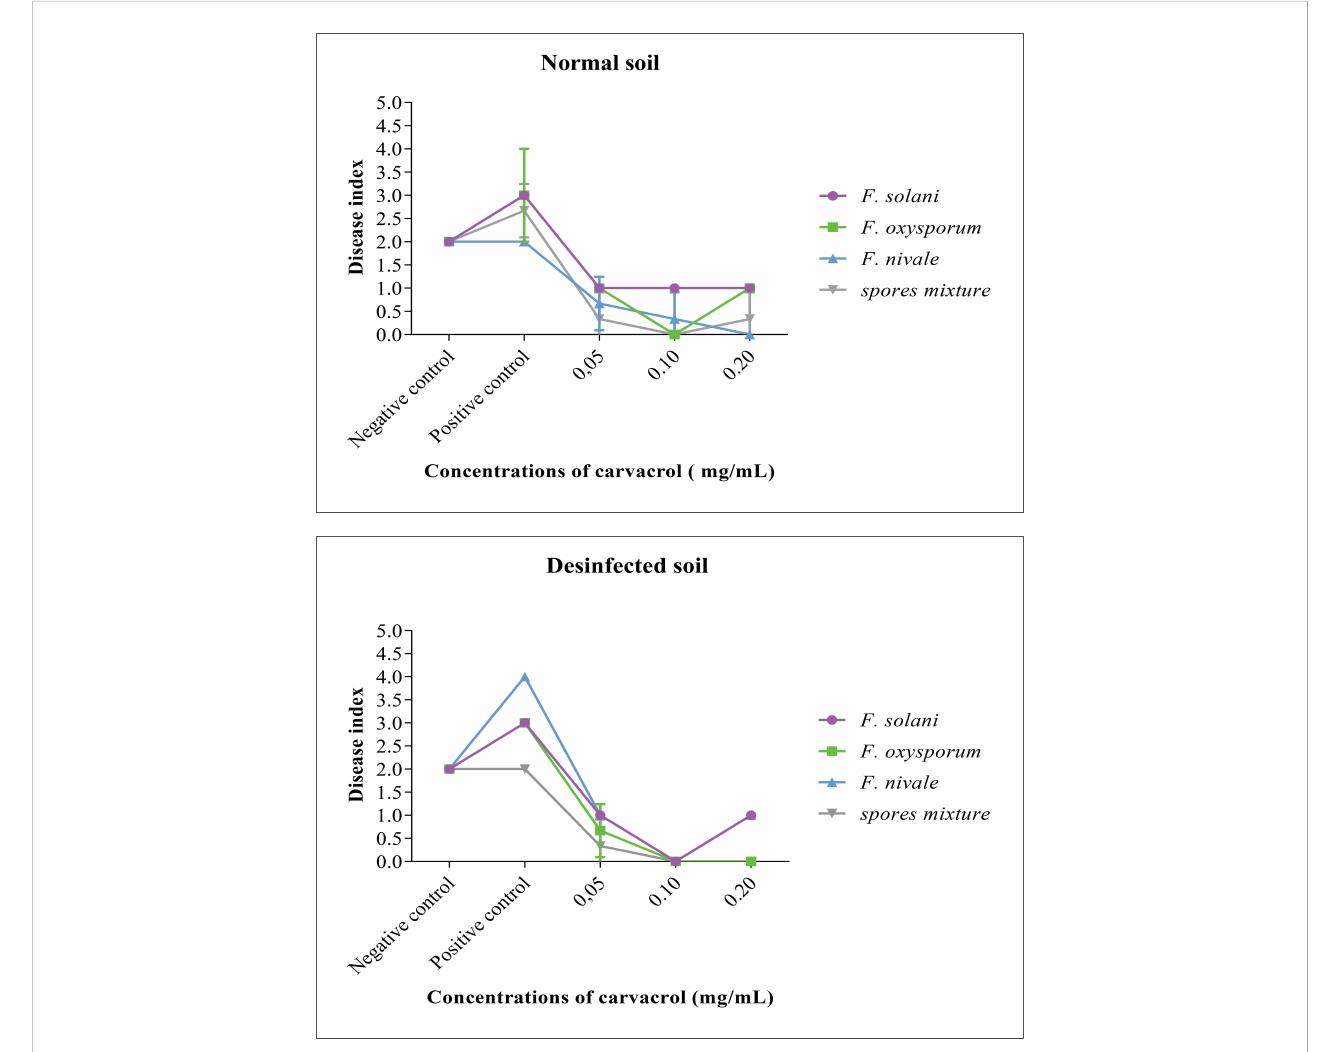
FIGURE 3 The disease index and the evolution of the average symptom severity on infested ryegrass after 7 weeks of preventive treatment with carvacrol. The results differ signi fi cantly at a threshold a = 5% (Two-way ANOVA, Turkey test). Error bars show standard